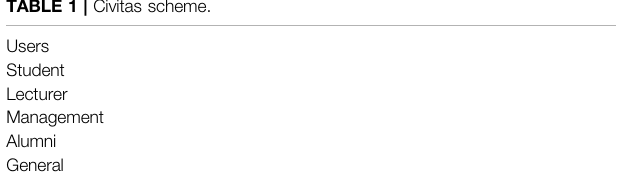
TABLE 1 | Civitas